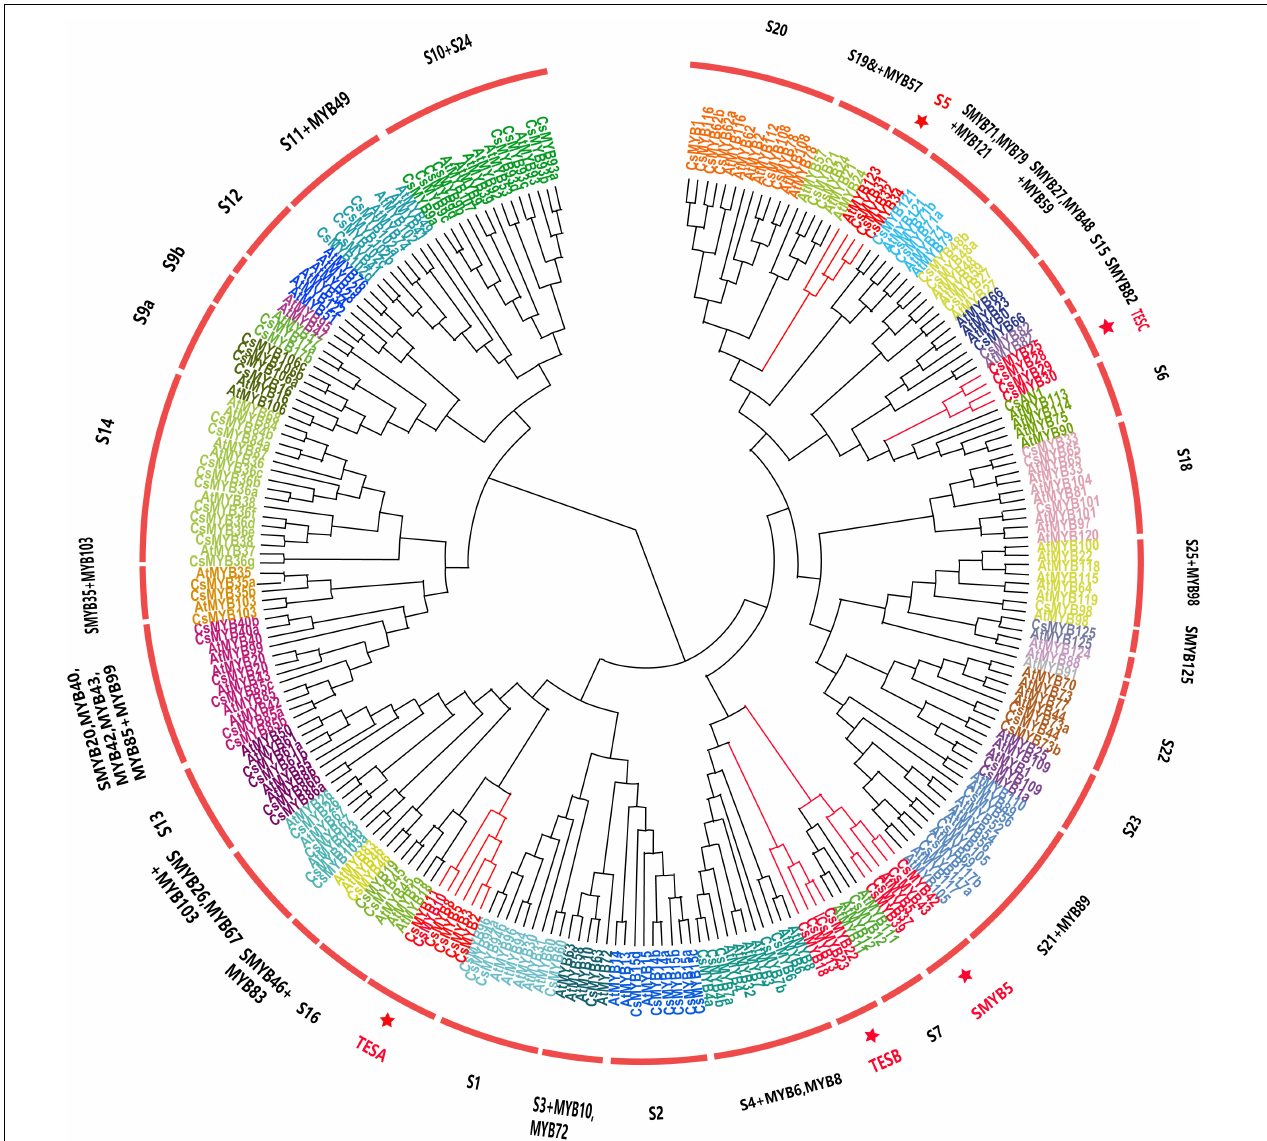
FIGURE 1 | Phylogenetic analysis of the R2R3-MYB families in C. sinensis and A. thaliana . A neighbor-joining phylogenetic tree was constructed from 244 protein sequences including all R2R3-MYB proteins from C. sinensis (118) and A. thaliana (126). Subgroups within each clade were given a different color; meanwhile, the same color indicates the genes are in the same subgroup. Subgroup short names are included next to each clade to simplify nomenclature. Subgroups that evolved and expanded exclusively in the C. sinensis genome are highlighted in red and marked with a red star. TESA, tea expanded subgroup A; TESB, tea expanded subgroup B; TESC, tea expanded subgroup C; SMYB5, subgroup MYB5; S5, subgroup